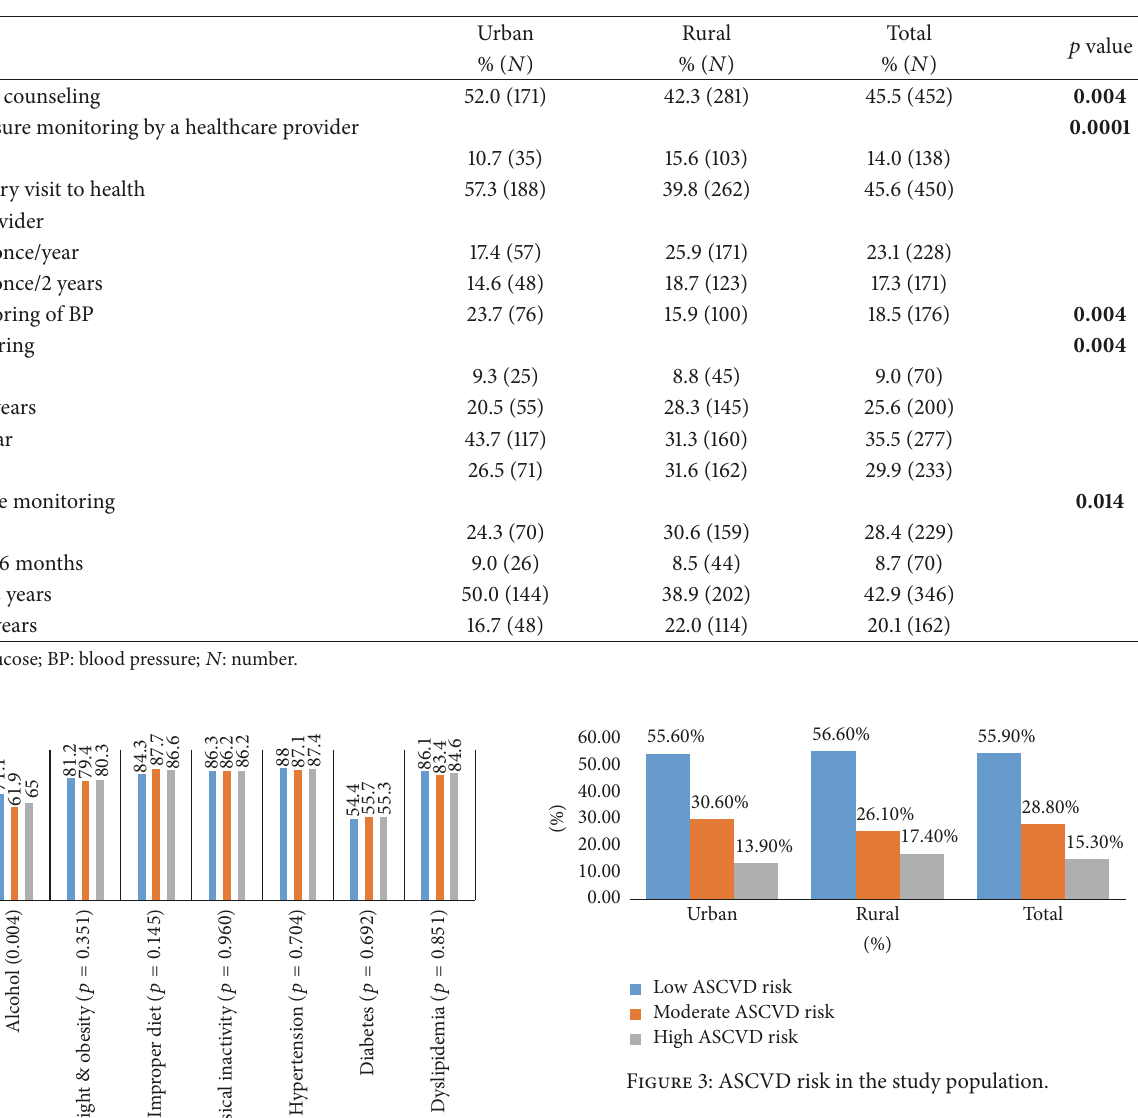
Table 5: Counseling and monitoring parameters at baseline.